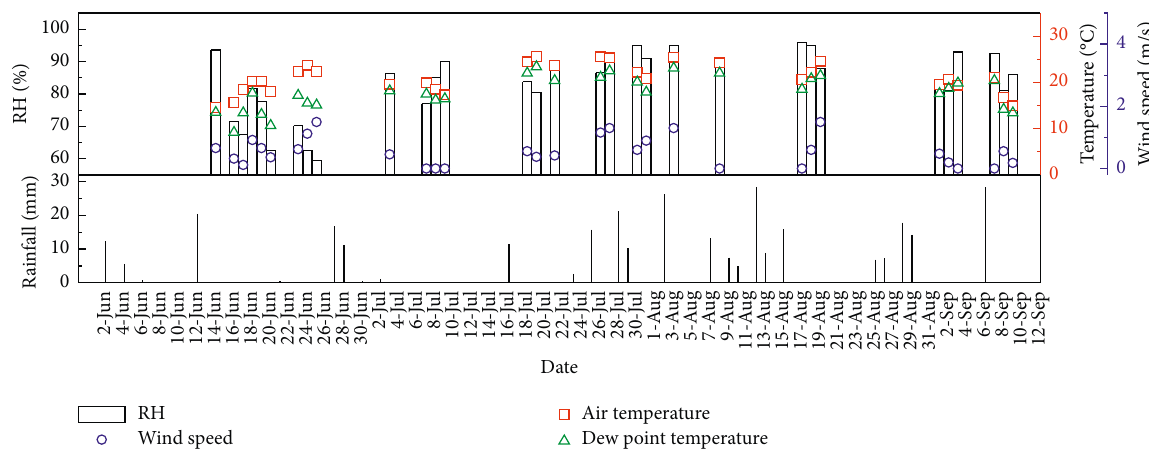
Figure 5: The rainfall from June to September and the meteorological factors during dew evaporation in 2020. Table 2: Correlation coefficients between wind speed and par- ticulate matter interception amount.